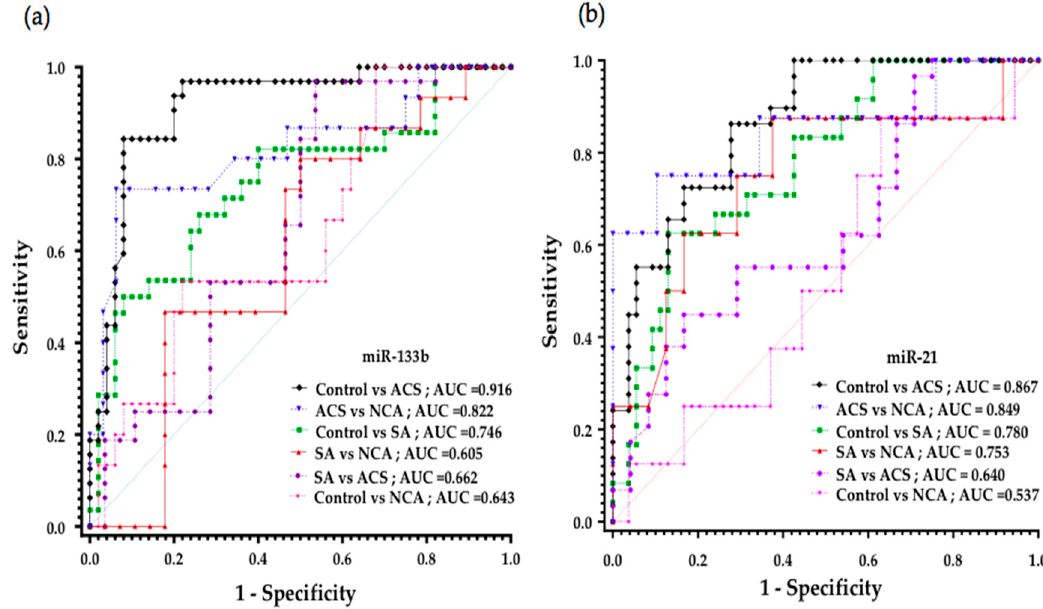
Figure 7. Diagnostic potential of circulating miR-133b and miR-21 as analyzed by ROC curve in di ff erent clinical categories of CAD: ( a ) ROC curve of miR-133b in di ff erent categories of CAD. Diagnostic potential of miR-133b as represented through AUC values was 0.916 for ACS, 0.746 for SA and 0.643 for NCA category as compared to control subjects; ( b ) ROC curve of miR-21 in di ff erent categories of CAD. Diagnostic potential of miR-21 was 0.867 for ACS, 0.780 for SA and 0.537 for NCA category as compared to control subjects.